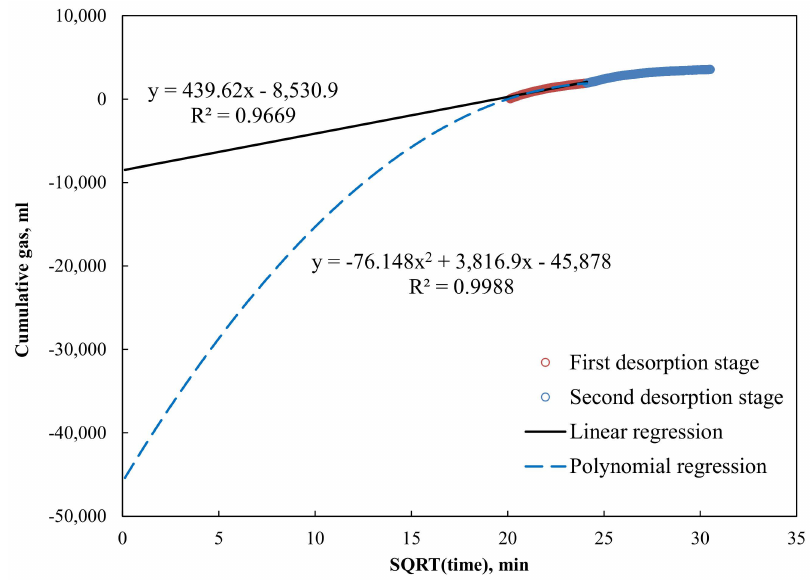
Figure 5. Extrapolation of canister desorbed gas data extrapolated to the true “time zero” to determine the lost gas volumes of 8.53 L and 45.88 L by linear regression and polynomial regression,